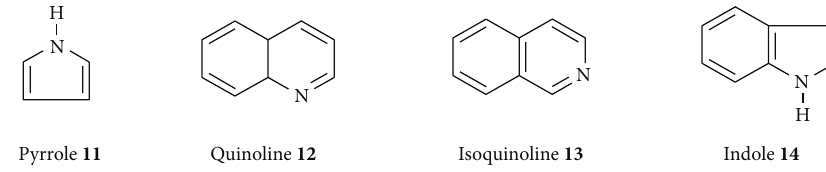
Figure 3: Typical basic structure of